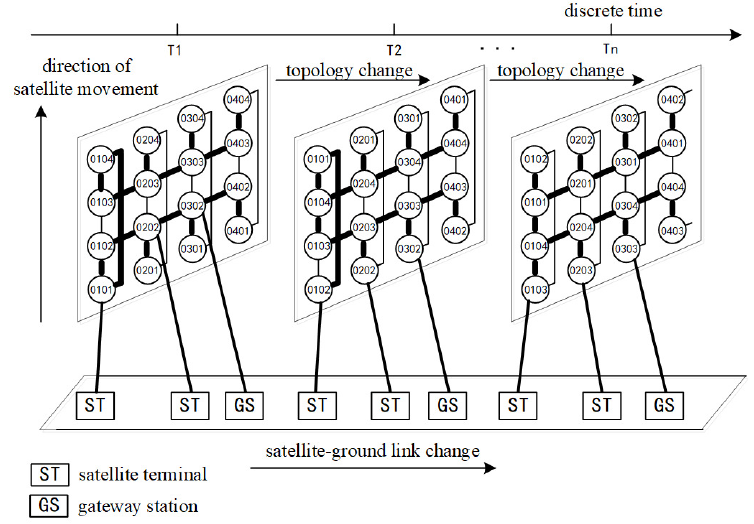
Figure 4. The LEO constellation network discrete